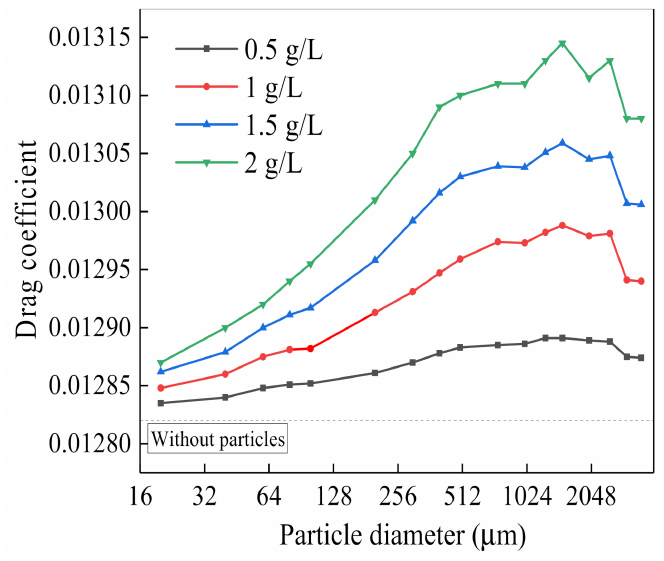
Figure 18. The airfoil drag coefficient with the particle diameter under different particle